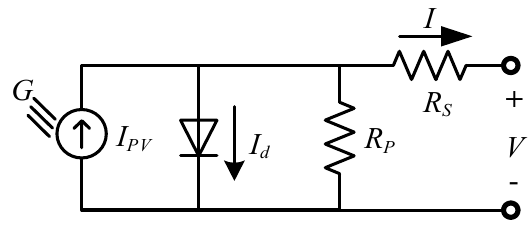
Figure 1. Solar cell model.